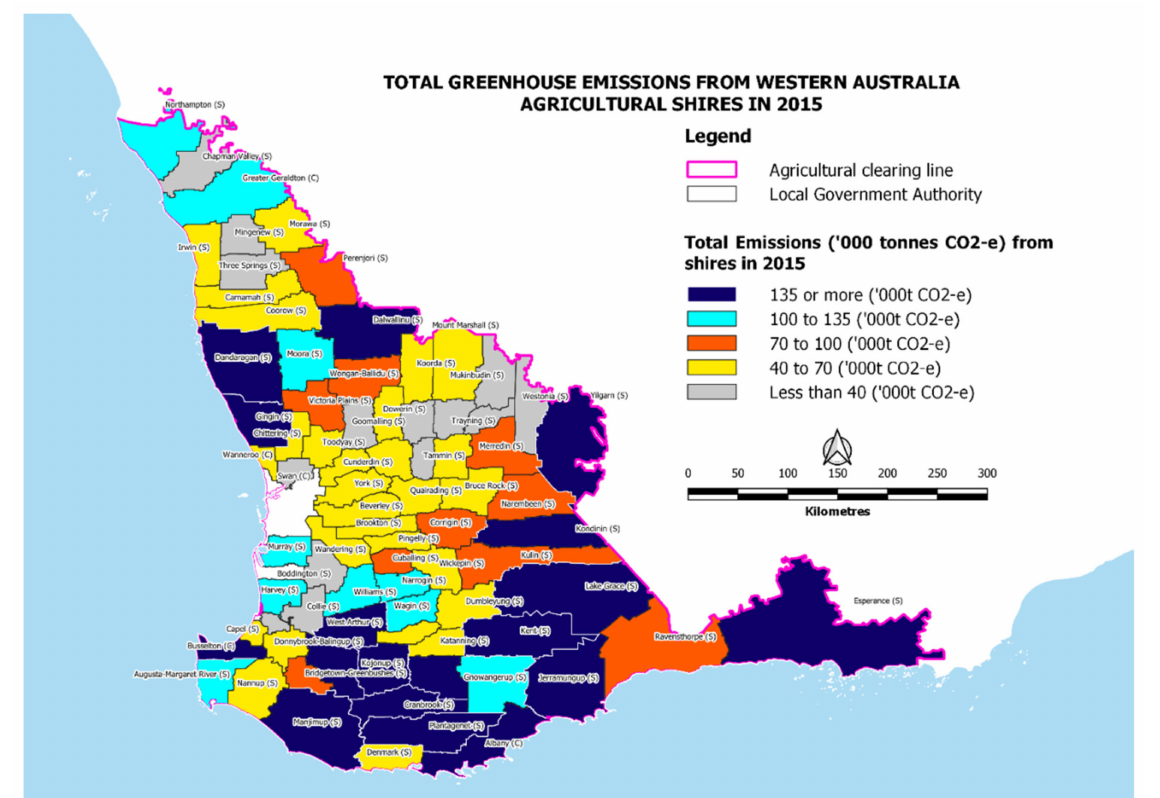
Figure 2. Shire emissions in 2015. Source: Kingwell